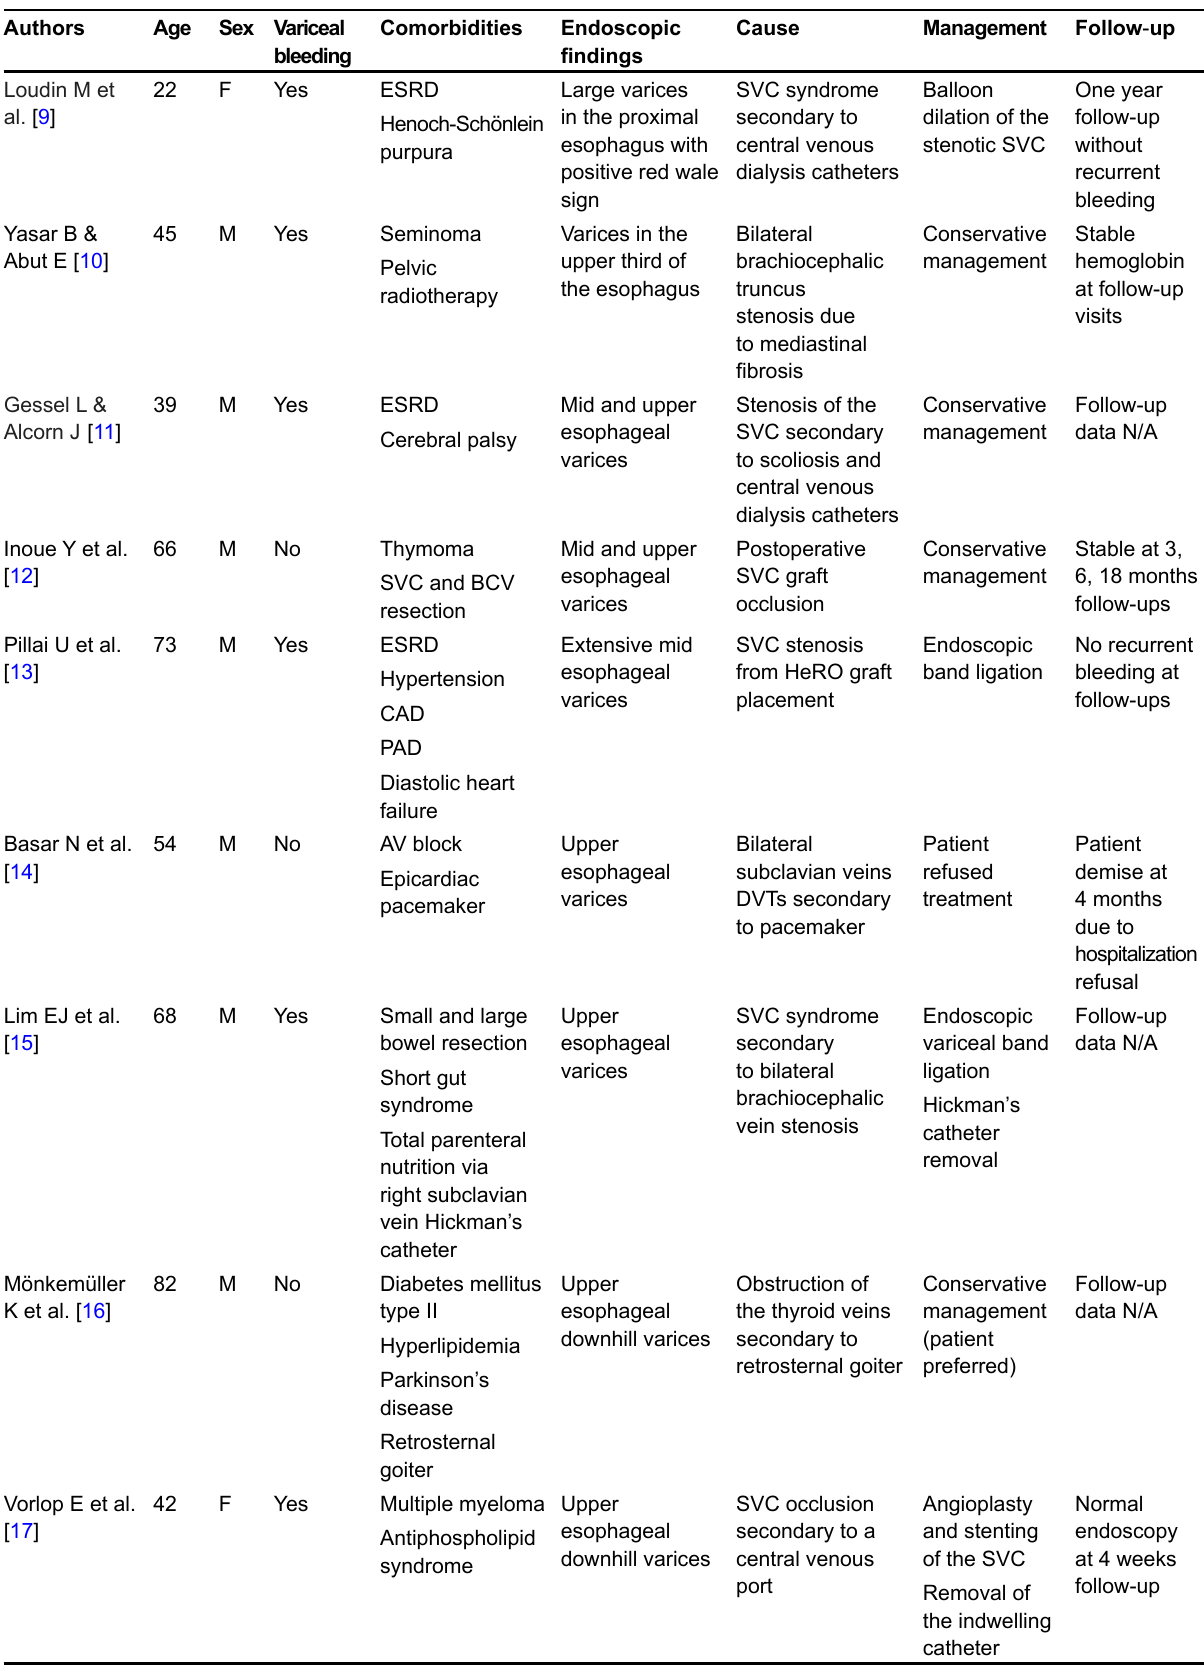
Table 1. Demographics, presentation, causes and management of patients with downhill varices ( continued )